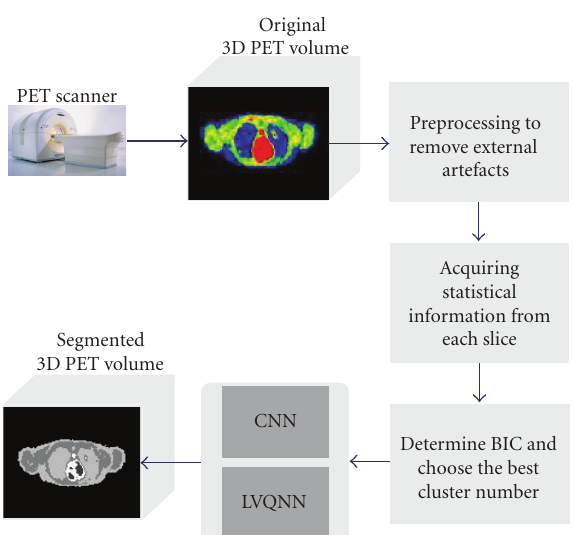
Figure 1: Proposed system for oncological PET volume